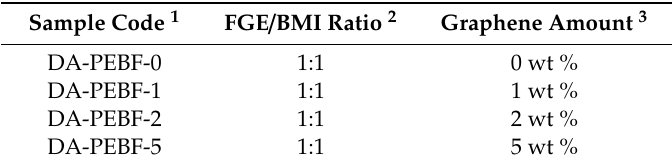
Table 1. Compositional characteristics of PEBF/graphene/BMI hybrids.